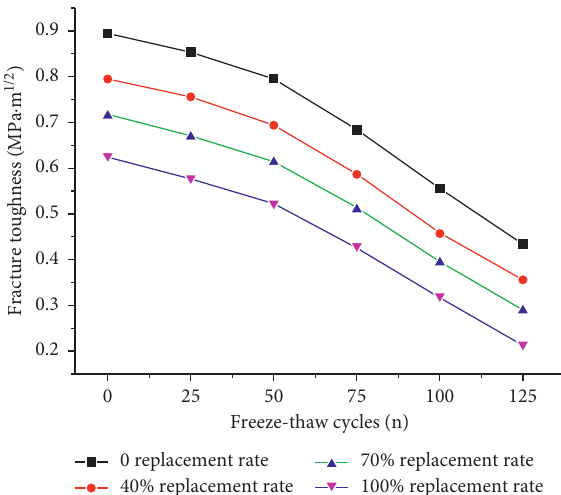
Figure 8: Fracture toughness of coal gangue concrete under freeze-thaw cycles.